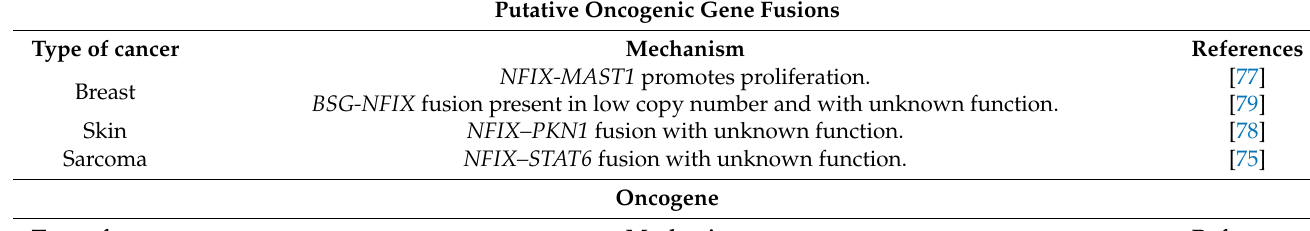
Table 1. Oncogenic and tumor suppressor roles of NFIX. Putative Oncogenic Gene Fusions